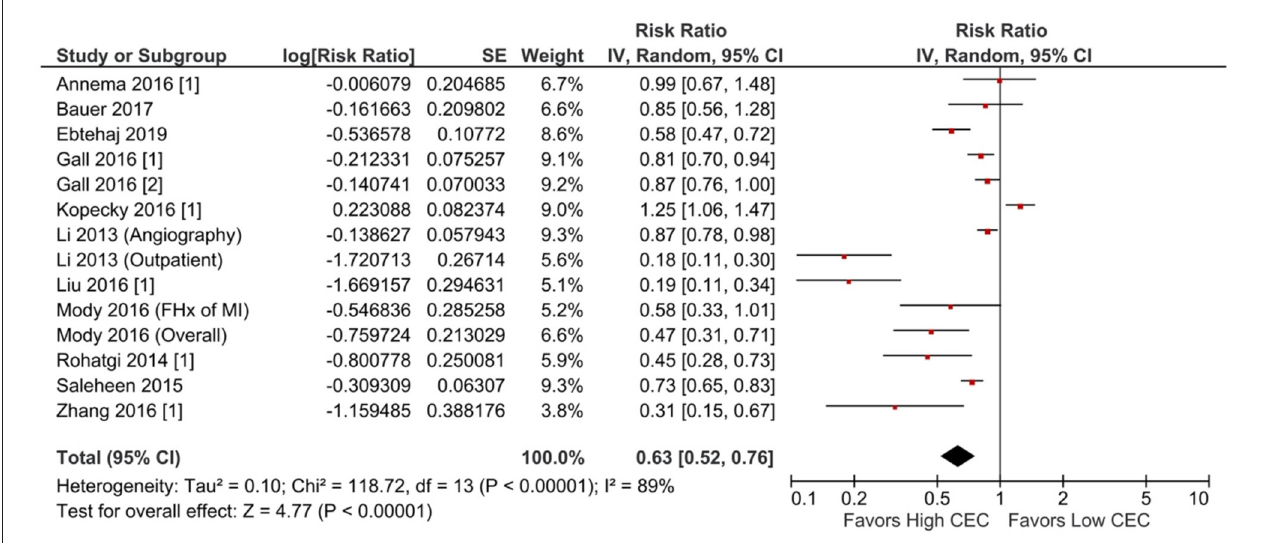
FIGURE 1 | Adverse cardiovascular event: High CEC vs. low CEC (RR) (14 studies). CEC, cholesterol efflux capacity; CI, confidence interval; df, degree of freedom; FHx, family history; IV, inverse variance; MI, myocardial infarction; RR, risk ratio; SE, standard error.